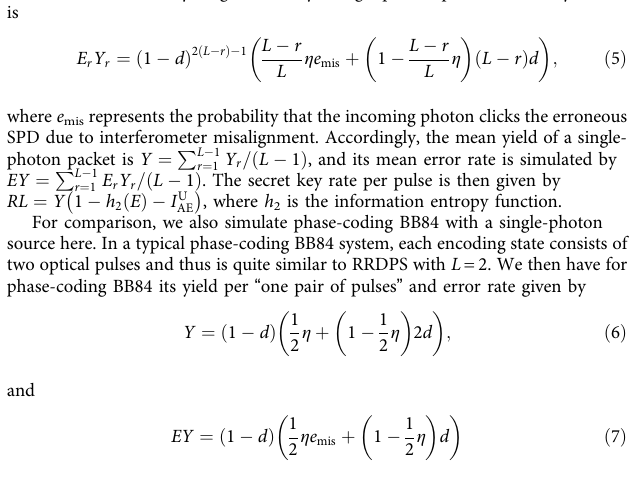
while the maximum transmission distance of the similar L = 5